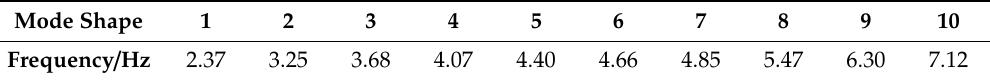
Table 2. Calculated natural frequency of